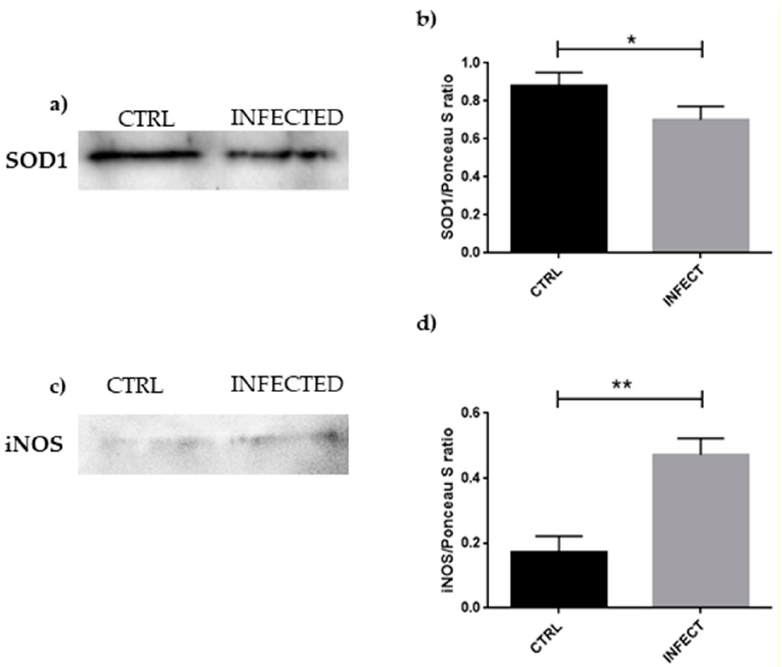
Figure 3. ( a ) Evidence of a significant decrease in SOD1 expression in HCN-2 culture medium after SARS-CoV-2 infection, suggesting impairment of ROS reduction. ( b ) Densitometric analysis of SOD1, * p < 0.05. ( c ) Evidence of significant increase in iNOS expression in HCN-2 culture medium after SARS-CoV-2 infection, as an indicator of reactive species production. ( d ) Densitometric analysis of iNOS, ** p < 0.01.